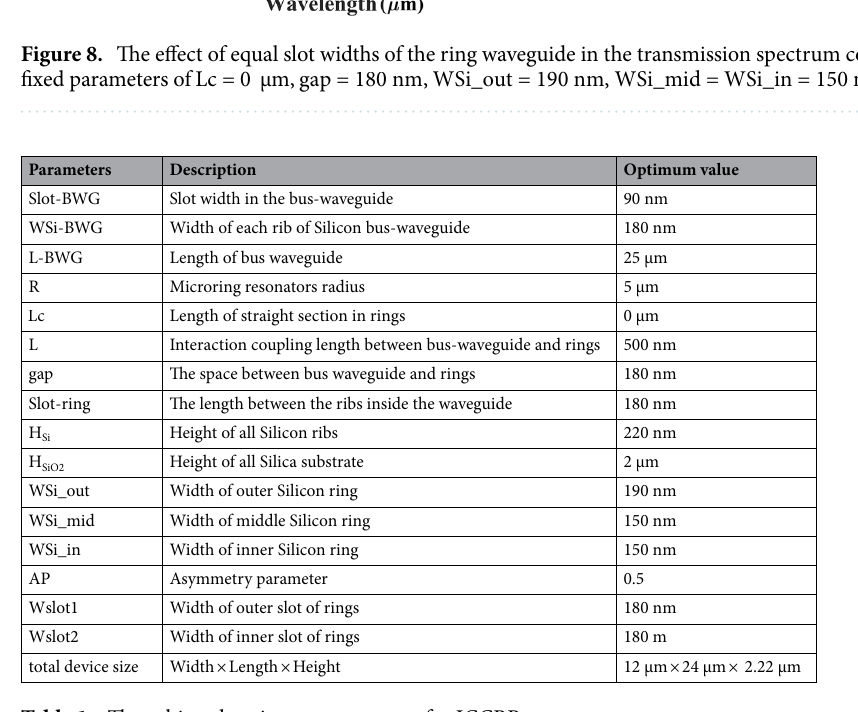
Table 1. The achieved optimum parameters for ICCRR